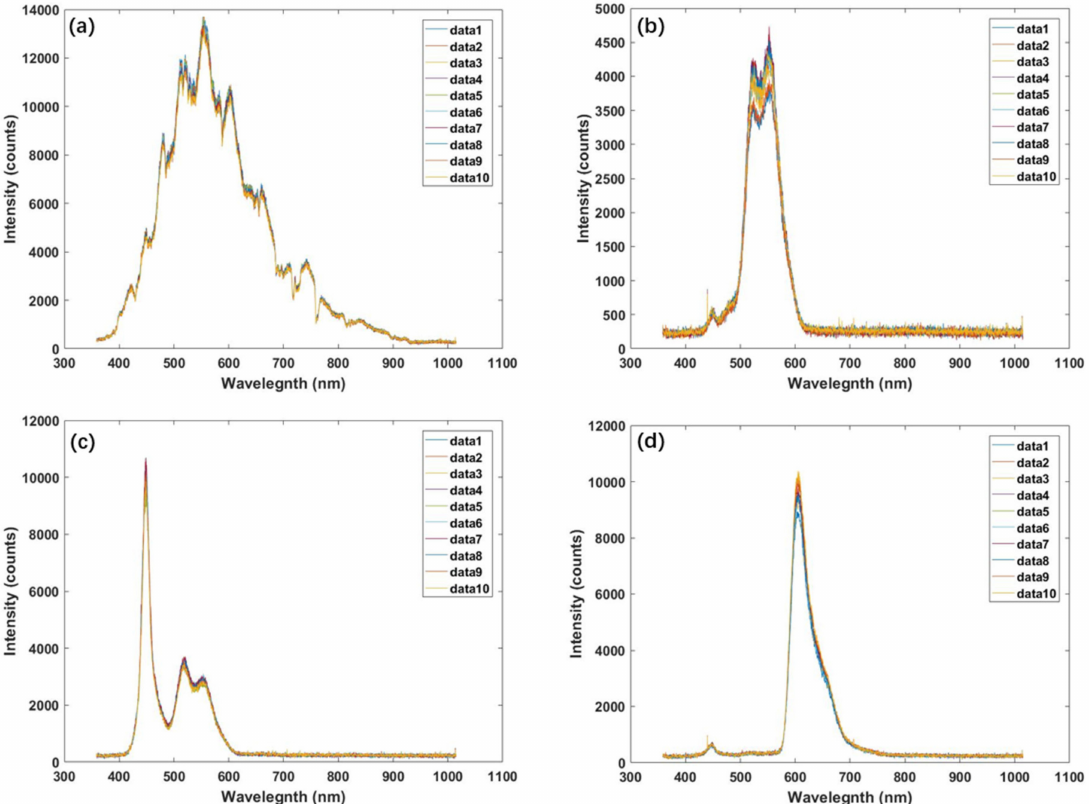
Figure 3. ( a ) 10 sets of sunlight spectrum data collected every 10 s. ( b ) 10 sets of screen green light spectrum data collected every 10 s; ( c ) 10 sets of screen blue light spectrum data collected every 10 s; ( d ) 10 sets of screen red light spectrum data collected every 10